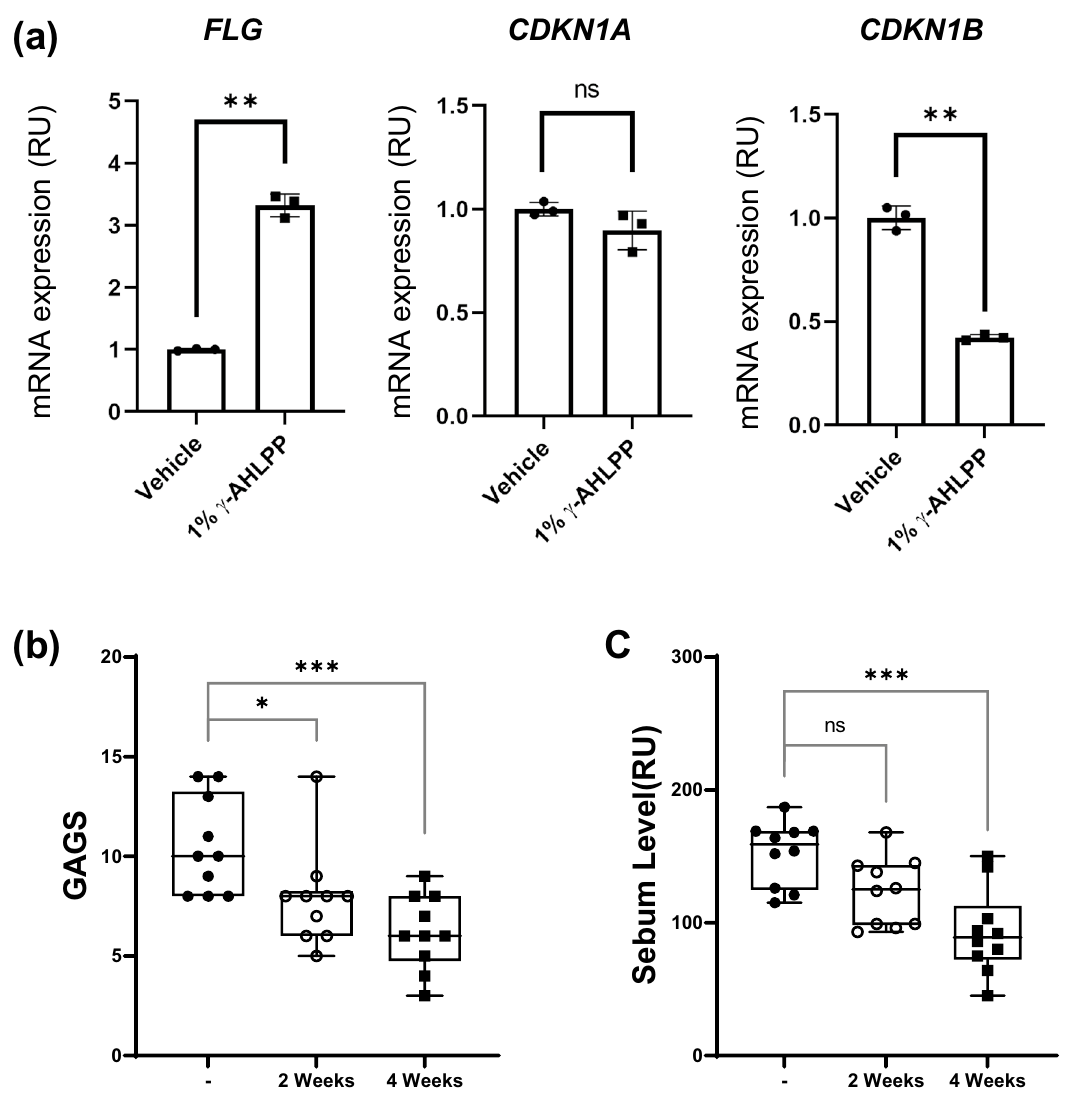
Figure 6. A mixture of plant extracts from agrimonia, houttuynia, licorice, peony, and phellodendron (hereafter AHLPP). ( a ) Deposition of γ-irradiated AHLPP extract in hydrogel-polymer-regulated mRNA expression of co-cultivated cells. One percent of γ-irradiated AHLPP extract was deposited in hydrogel by volume (vol %) and incubated with HaCaT cells for 48 h. Harvested cells were analyzed for mRNA quantitation. The same volume of water was used as vehicle control. Asterisks indicate statistical significance. T-test revealed statistical significance. ** p < 0.01, ns non-significant. ( b ) Global Acne Grading System (GAGS) was determined after treatment of the AHLPP extract with hydrogel polymer for 2 and 4 weeks on human inflamed acne skin. ( c ) Sebum level of human skin was assessed after treatment of the AHLPP extract with hydrogel polymer for 2 and 4 weeks. Ten individuals participated in the clinical analysis. One-way ANOVA revealed statistical significance. * p < 0.05, ** p < 0.01, *** p < 0.005, ns